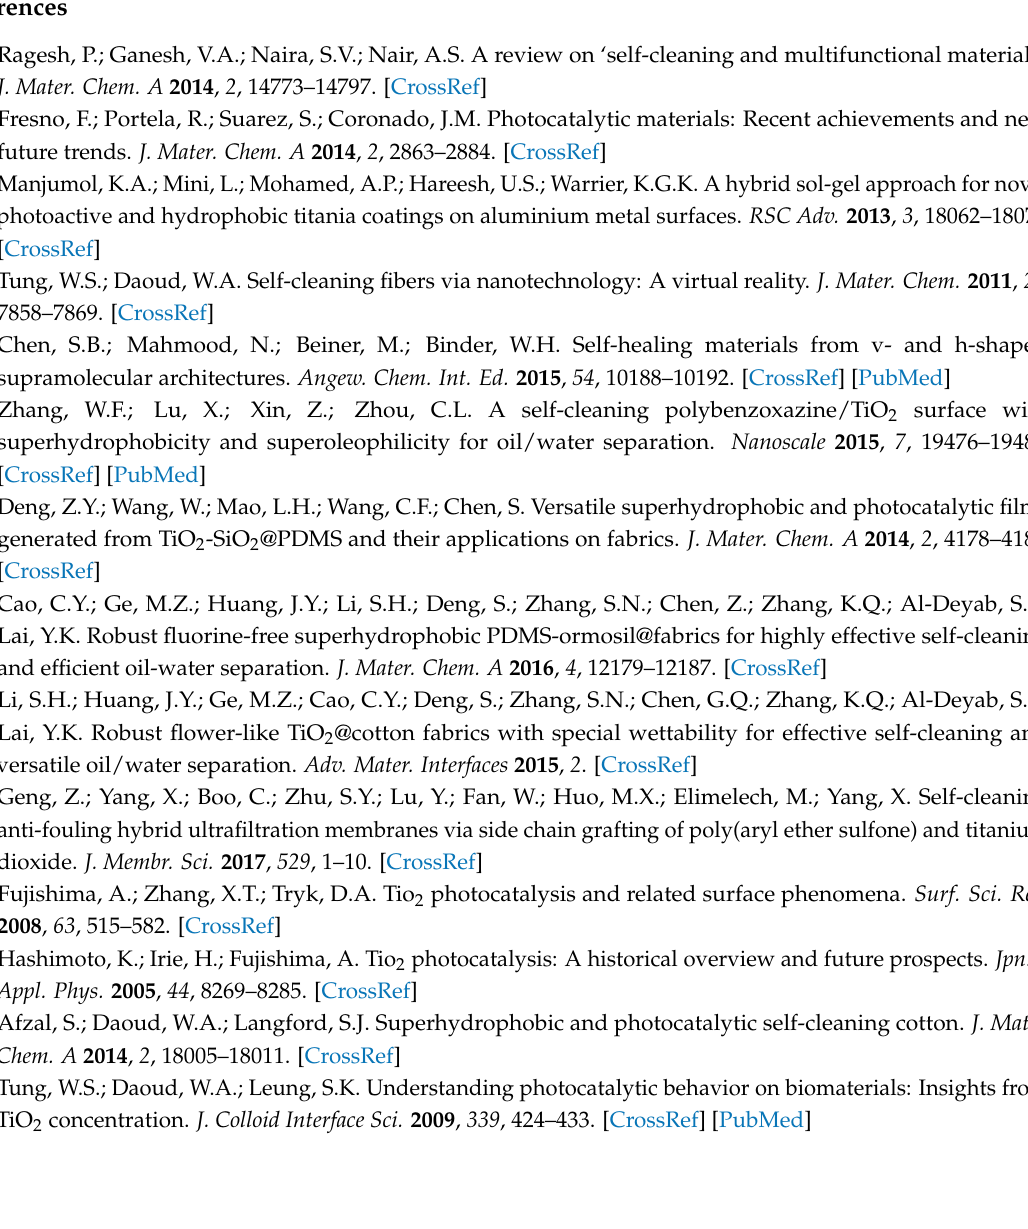
Figure S1: EDS of 10% TiO 2 -coated cashmere. Figure S2: UV-vis diffuse reflectance spectra of pristine and coated cashmere. Figure S3: Absorption spectra of MO in presence of cashmere fabrics with (a) 5% and (b) 10% TiO 2 nano-coatings after the 1st washing. Figure S4: Absorption spectra of MO in presence of cashmere fabric with (a) 5% and (b) 10% TiO 2 nano-coating after the 2nd washing. Figure S5: Absorption spectra of MO in presence of cashmere fabric with (a) 5% and (b) 10% TiO 2 nano-coating after the 3rd washing. Figure S6: UV-vis diffuse reflectance of cashmere with (a) 5% TiO 2 coating and (b) 10% TiO 2 coating after washing. Figure S7: Optical image showing water contact angle on pristine